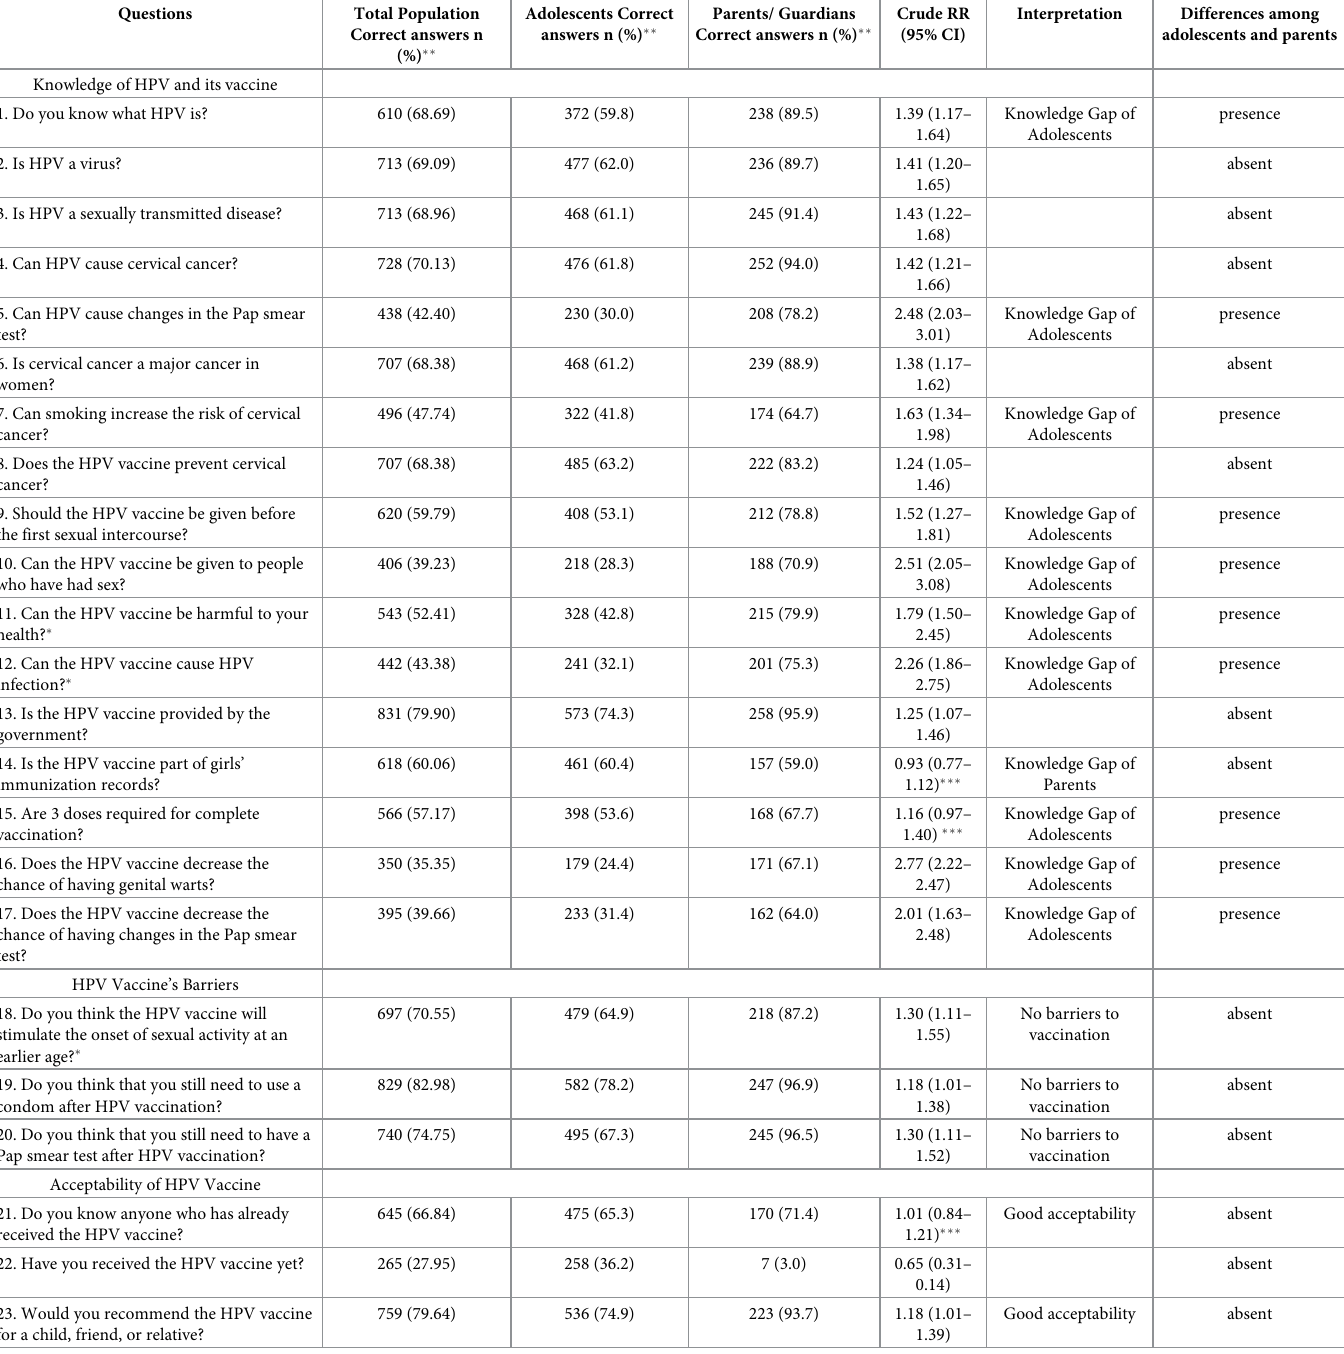
Table 2. Correct answers, differences in knowledge about HPV, its vaccine, acceptability and barriers to vaccination among adolescents and parents/guardians. Sao Paulo, Brazil,